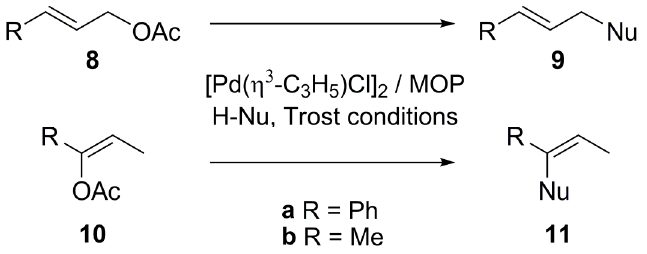
Scheme 4. ”Memory effect” with axial MOP